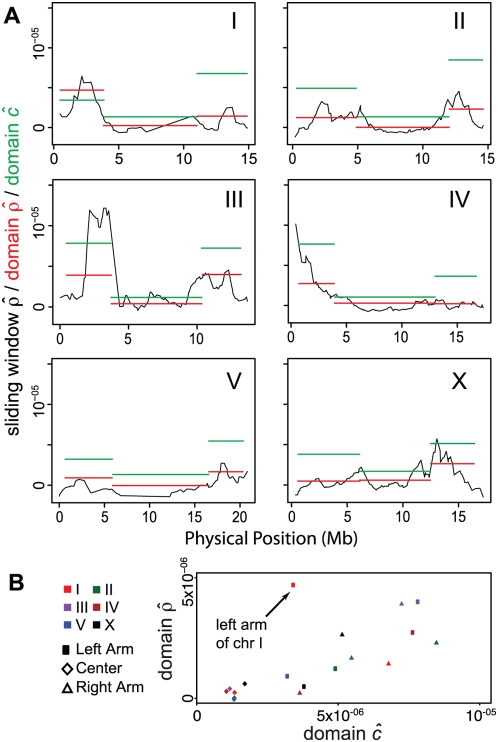
Population genetic and meiotic recombination rate estimates.(A) The population effective recombination parameter estimate  (per base pair) is plotted in black for sliding windows of 2 Mb centered on each SNP. Estimates are derived from the rate of decay of linkage disequilibrium with physical distance. Red bars indicate the estimates of  for whole recombination rate domains (arms and centers), and green bars indicate , the estimated meiotic recombination rate per base pair, inferred for each domain from the recombination fraction observed in RIAILs (Figure 1; Table 1). (B) Domain-specific estimates of ρ and c are correlated, and  is about 40% the magnitude of .